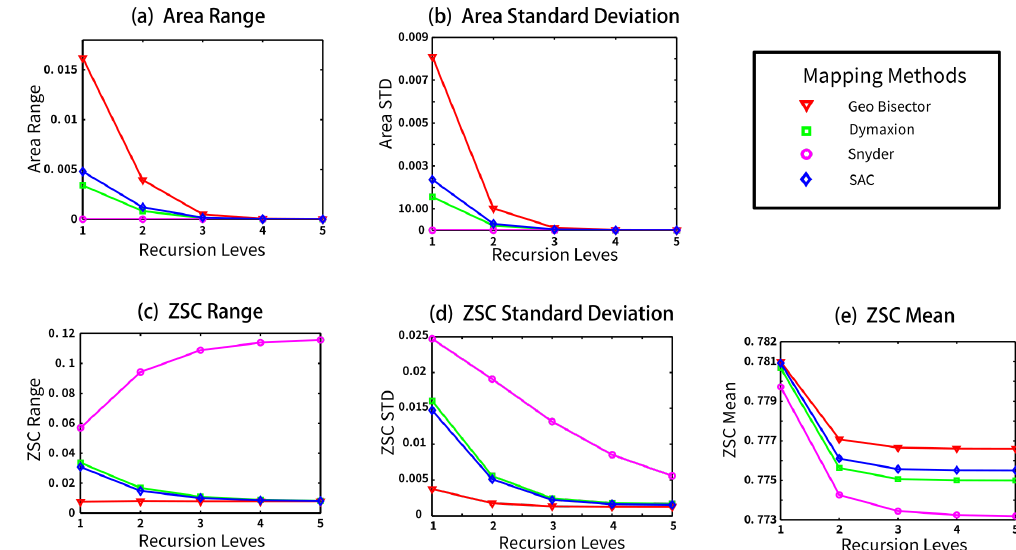
Figure 20. Graphs of the five statistics of the area and ZSC response measurements for each method as a sequence by recursion level (level 1 to level 5). These results are for the icosahedron using the 9-fold density